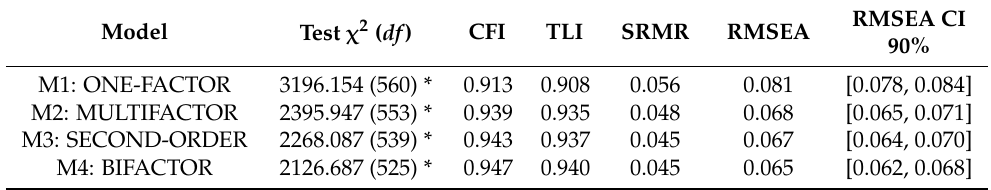
Table 4. Fit indices for alternative measurement models for the Antisocial Preferences Scale. Model